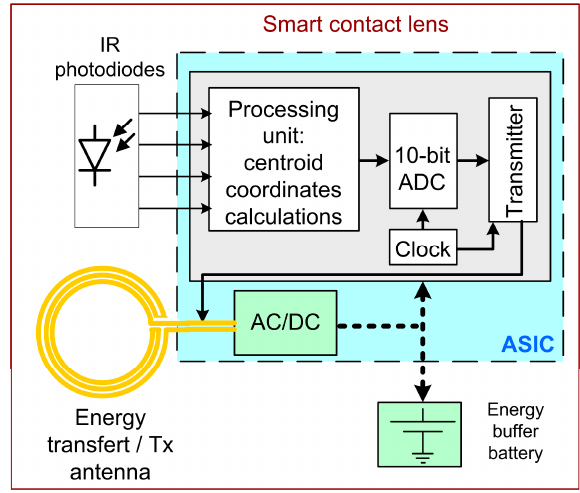
Figure 1. Block diagram of the smart contact lens including a simplified description of the ASIC functions.